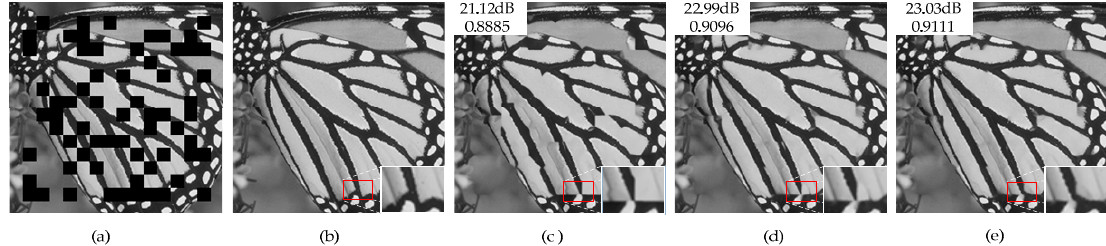
Figure 17. Subjective quality comparison of the proposed correction and adaptive scan order on the Peppers image with 16 × 16 regular consecutive loss. The reconstructed details are shown in the lower right corner of each image. ( a ) The received image. ( b ) The original image. ( c ) The reconstructed image with scenario ‘Cor(off)-Ord(on)’. ( d ) The reconstructed image with scenario ‘Cor(on)-Ord(off)’. ( e ) The reconstructed image with scenario ‘Cor(on)-Ord(on)’.